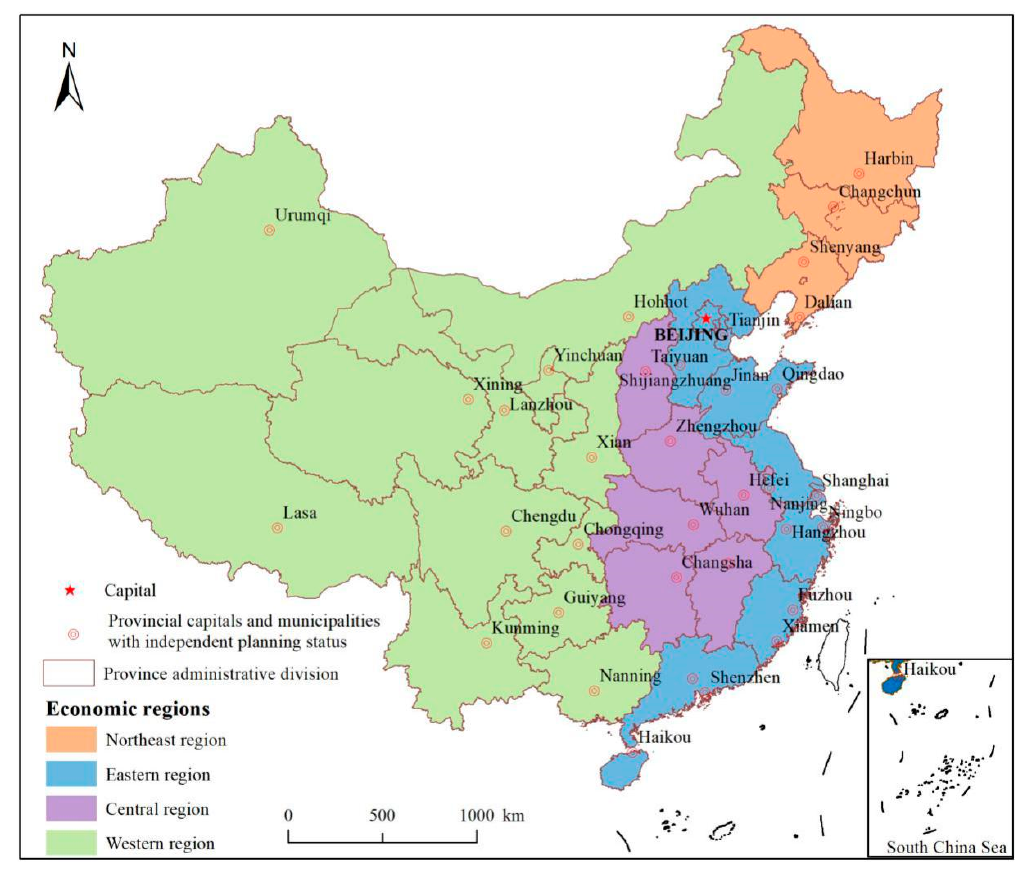
Figure 8. The four major economic regions of China.